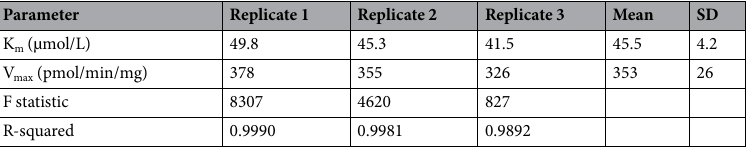
Table 1. Derived kinetic parameters for the conversion of asymmetric dimethylarginine to L-citrulline by dimethylarginine dimethylaminohydrolase 1. Kinetic constants ( K m , V max ) for L-citrulline formation